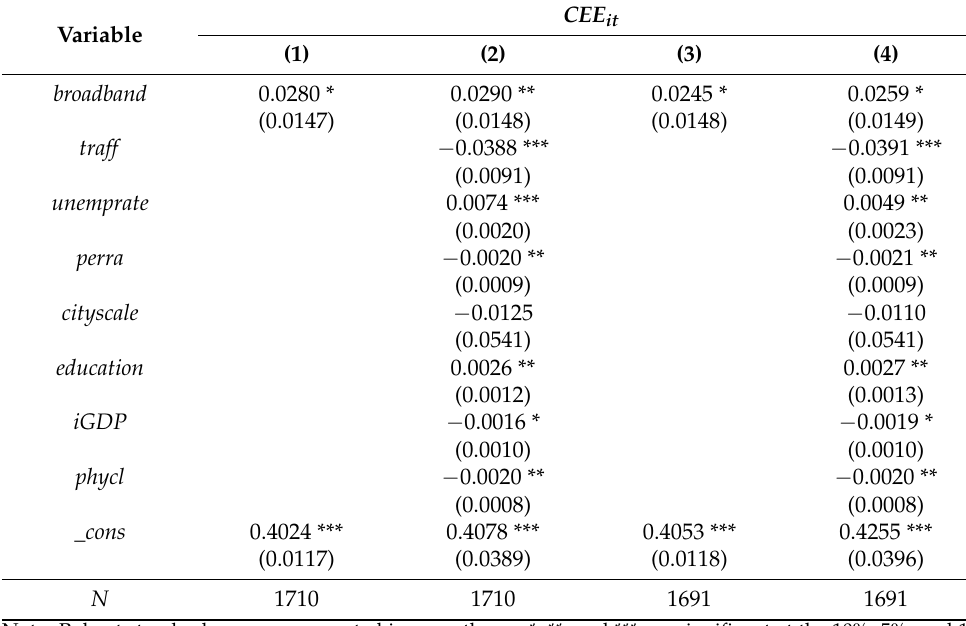
Table 3. Benchmark regression